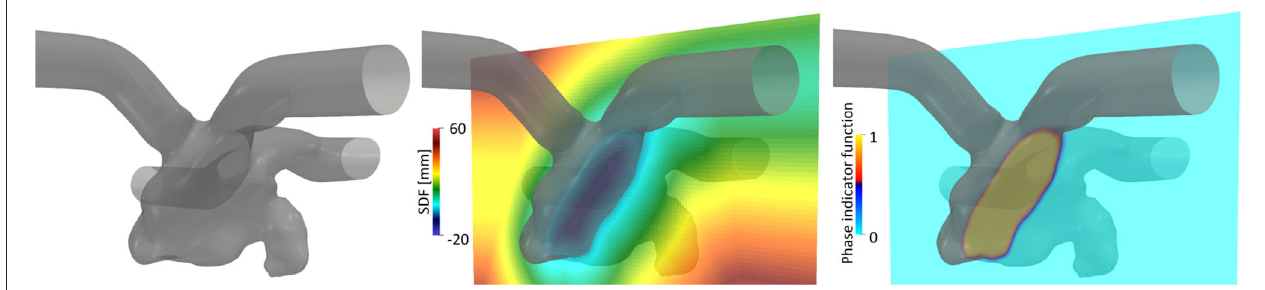
FIGURE 2 | Left atrial surface (left) and spatial distributions of the signed distance function (SDF), φ (center), and phase indicator function, κ , computed using the SDF (right) in a representative cross-sectional